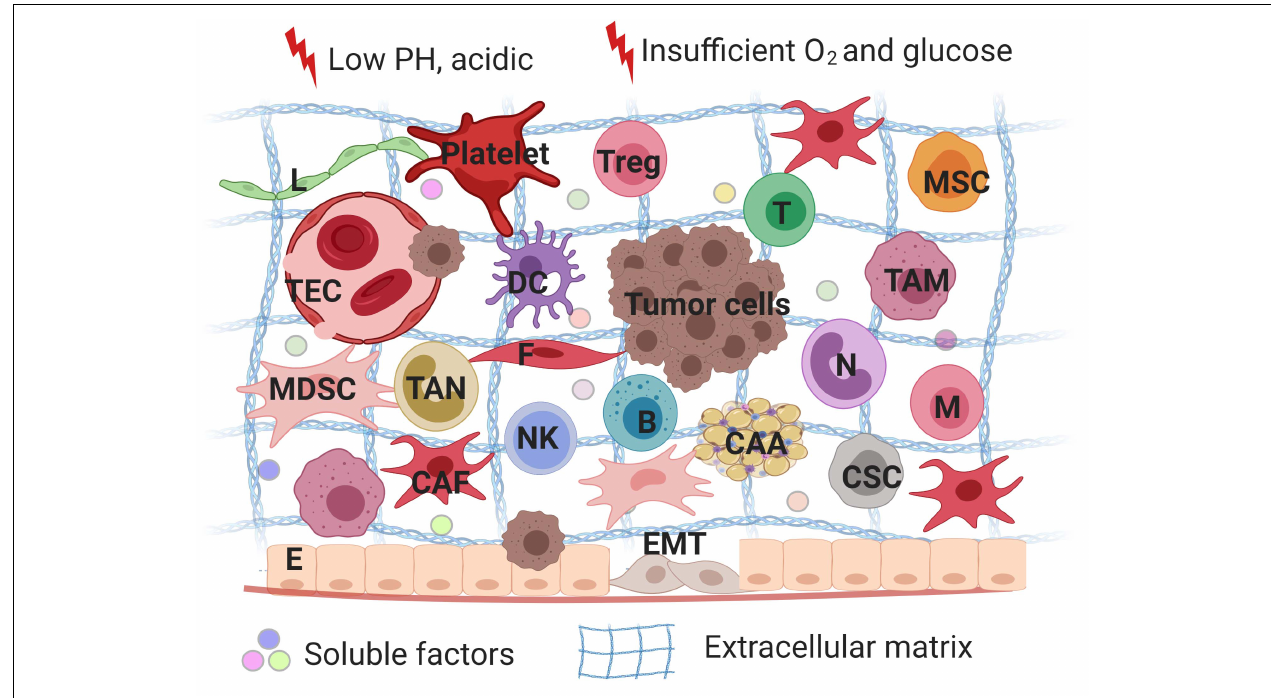
FIGURE 1 | A schematic overview of tumor microenvironments. Tumor microenvironment refers to the local biological environment where tumor cells exist, and are composed of tumor cells, stromal cells and immune cells. TME is involved in the initiation and maintenance of non-cell autonomous resistance by a variety of mechanisms, including hypoxia, low PH, shifts and polarizations in the immune cell population, vascular abnormalities and diverse stroma cells-derived secretomes, exosomes, soluble factors. TME serves as safeguard to tumor cells by providing mechanical support or secreting different cytokines to evade treatment. Treg, regulatory T lymphocytes; MSC, mesenchymal stem cells; T, T lymphocytes; B, B lymphocytes; DC, dendritic cells; N, neutrophils; M, macrophages; NK, natural killer cells; E, epithelial cells; F, fibroblasts; CAA, cancer-associated adipocytes; L, lymphatic endothelial cells; TEC, tumor endothelial cells; CSC, cancer stem